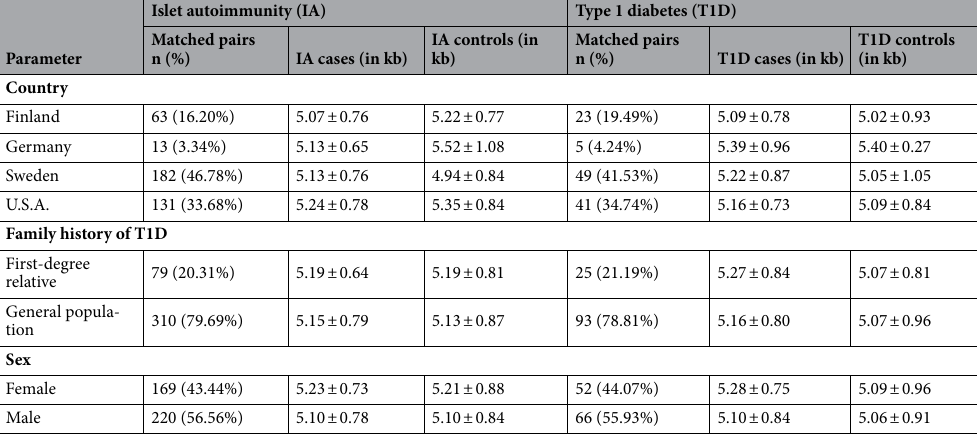
Table 1. Length of telomeres (kb) in study subjects by the status of islet autoimmunity (IA) and type 1 diabetes (T1D) in the Environmental Determinants of Diabetes in the Young (TEDDY) study. Telomere length data were available on both case and matched control subjects in 389 IA pairs and 118 T1D pairs. Computel was used to estimate the telomere length from the whole-genome sequence (WGS) data. Telomere length is presented as mean ± standard deviation (S.D.) in